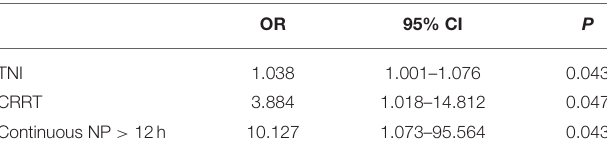
TABLE 3 | Multivariate analysis of neurological complications in V-A ECMO patients.